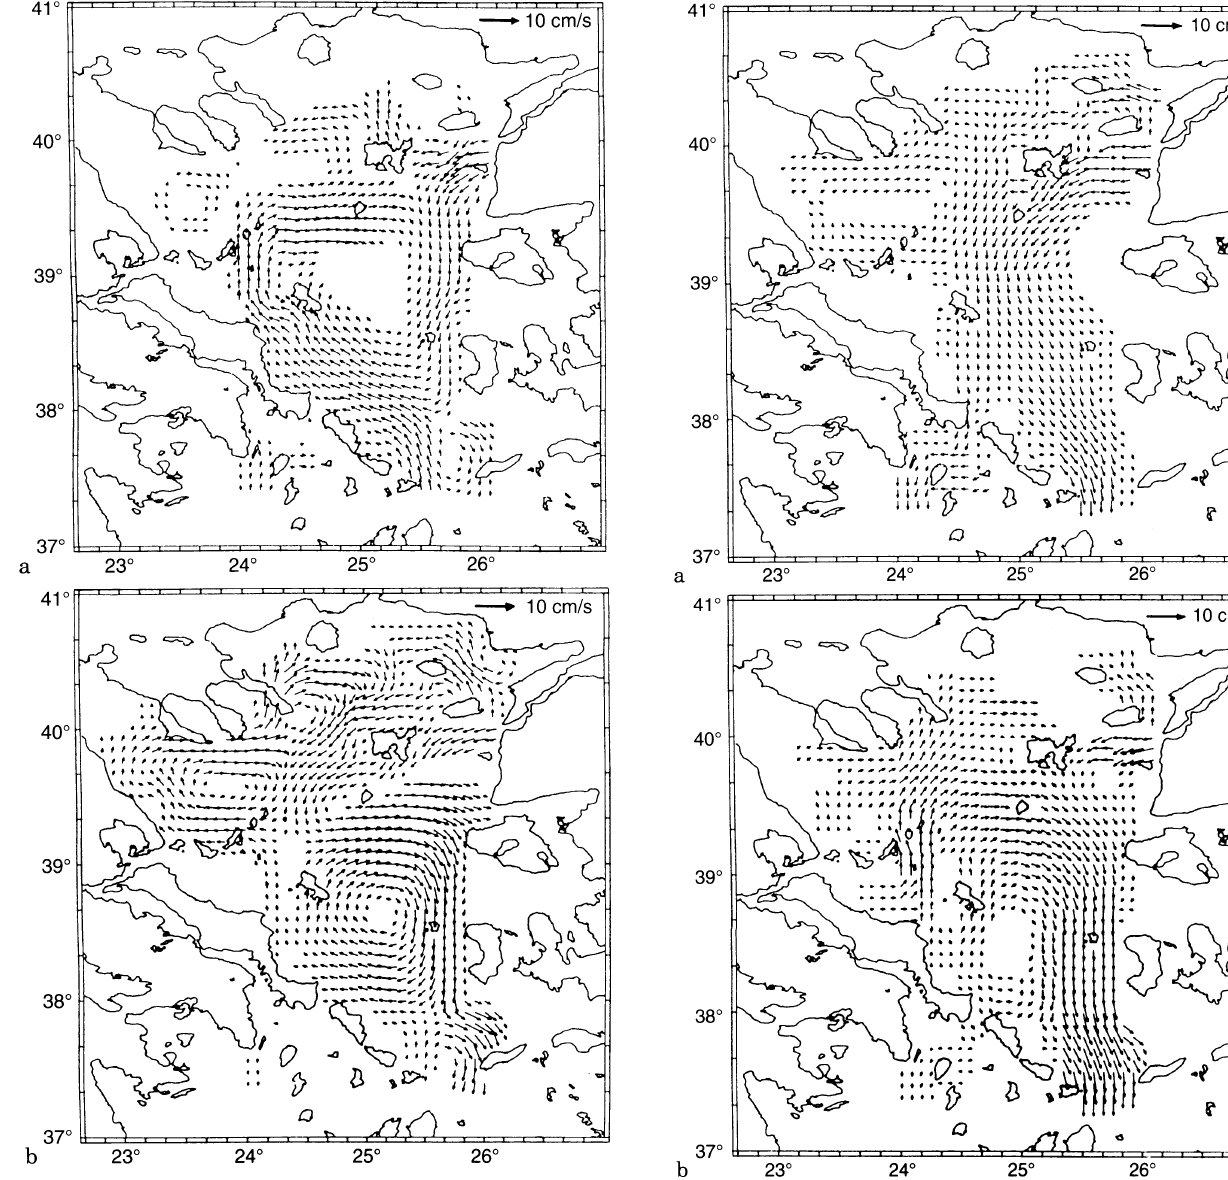
Fig. 10a,b. Simulated barotropic flow in the upper layer (40 m) of the North Aegean Sea, for a two-layer 2D flow model experiment; a for 30 June 1993; b for 03 July